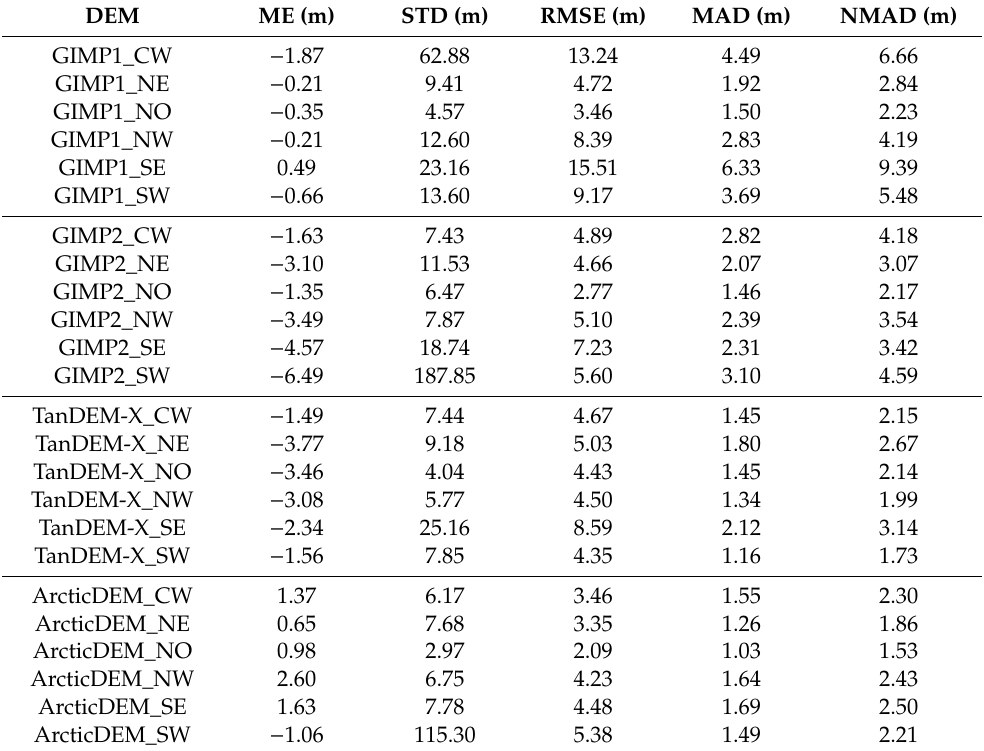
Table 8. Error analysis of GIMP1, TanDEM-X, GIMP2, and ArcticDEM in basin areas. DEM ME (m) STD (m) RMSE (m) MAD (m) NMAD